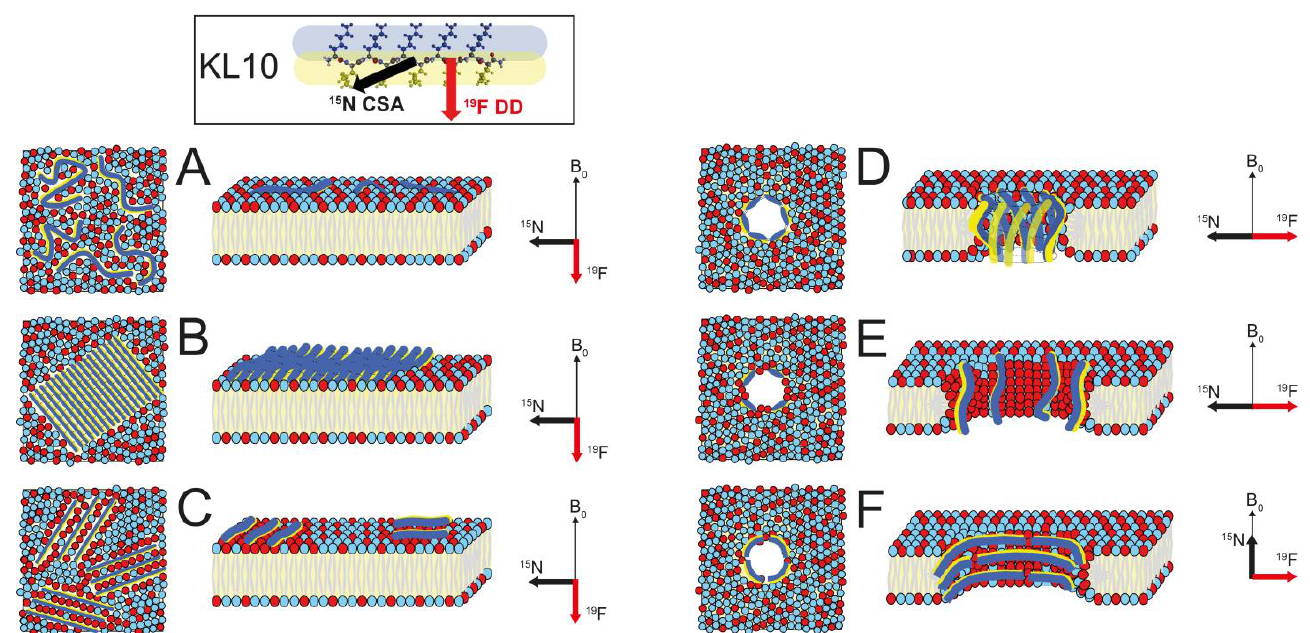
Figure 1. Different possible models of KL peptides in lipid bilayers, showing hydrophobic regions (lipid acyl chains, Leu side chains) in yellow, polar groups (uncharged lipid head groups) in light blue, cationic groups (Lys side chains) in dark blue, and anionic groups (charged lipid head groups) in red. Peptides are depicted in an extended β -strand conformation. The amphiphilic nature of the blue-yellow peptide structure of KL10 is seen in the box at the top. Superimposed on its molecular structure are the orientations of the relevant 15 N- and 19 F-NMR tensors as black and red arrows, respectively. The panels on the left show a top view of the membrane, and the central panels illustrate the respective side views. The panels on the right indicate the corresponding orientation of the NMR tensors in 15 N- and 19 F-labeled peptides when placed as an oriented membrane sample into the static magnetic field B 0 (which is aligned along the membrane normal). Model A: Monomeric peptides floating around on the membrane surface with high flexibility. Model B: Peptides on the membrane surface forming β -sheets that are stabilized by H-bonds between peptides. Model C: Peptides on the membrane surface that are indirectly assembled as an immobilized patch via clustering of anionic lipids between the strands. Model D: Peptides in a transmembrane orientation forming a β -barrel-type pore that is stabilized by H-bonds between peptides. Model E: Peptides forming a toroidal wormhole pore with peptides in a transmembrane orientation, with lipids in between the peptides, such that the pore interior is enriched in anionic lipids. Model F: Peptides lining the inside of a β -helix-type pore, with the long axis of the β -strand parallel to the membrane surface.